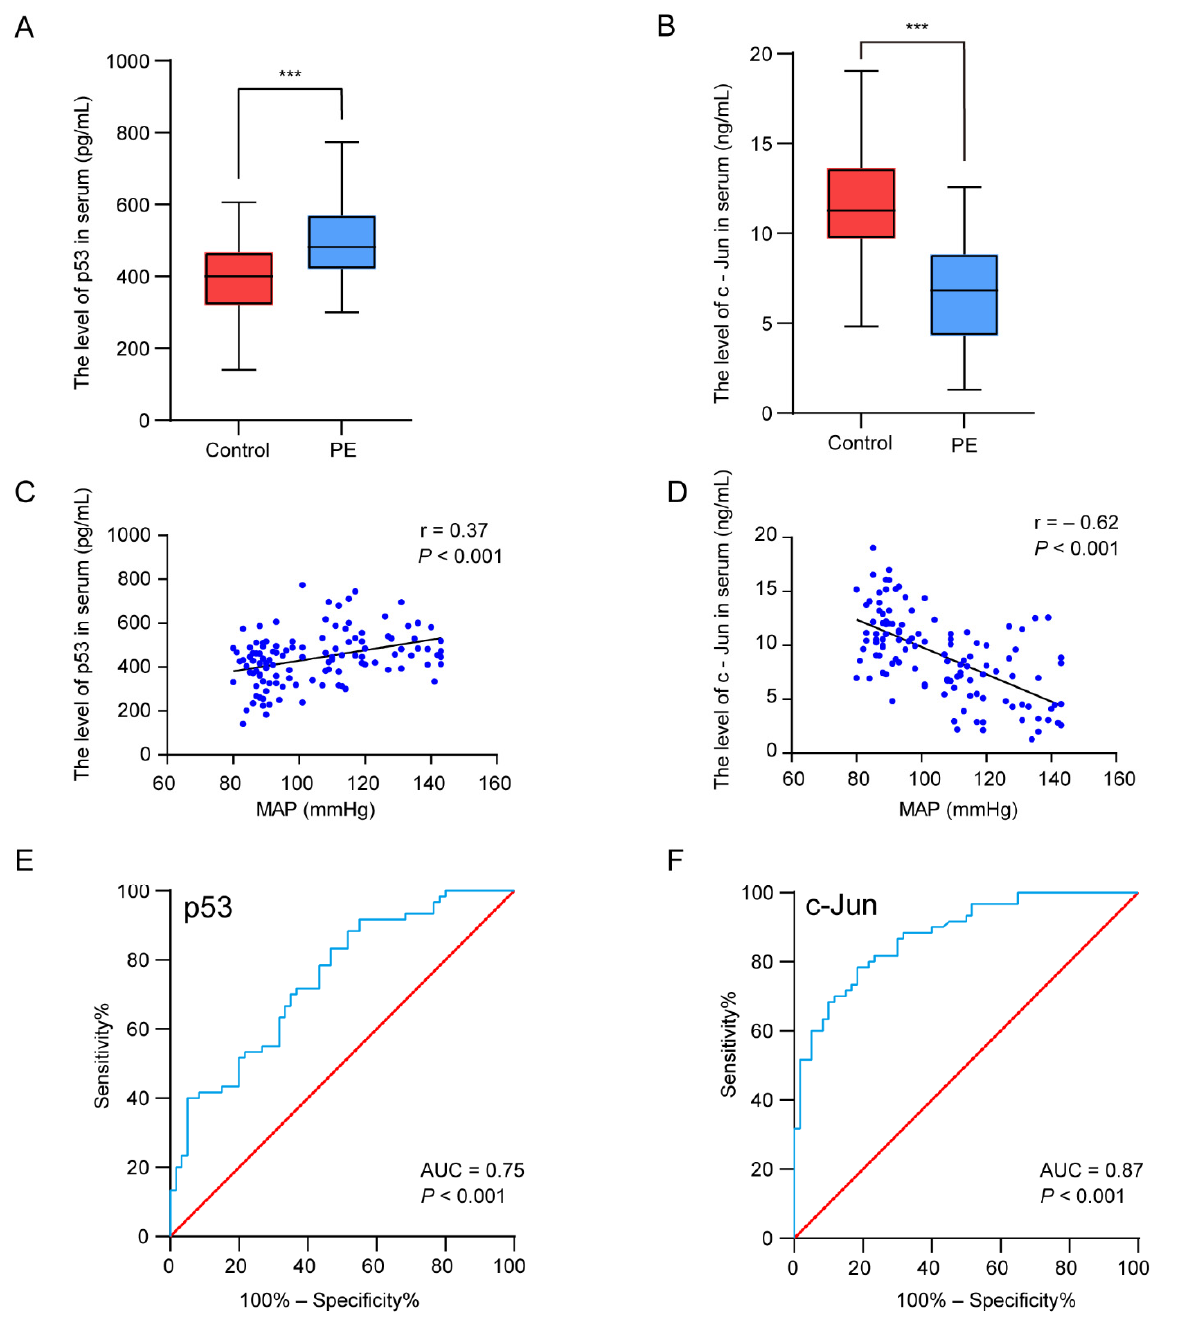
Figure 5. Experimental verification of the two hub genes, correlation analysis between the hub genes’ expression levels and clinical features, and the diagnostic accuracy analysis. ( A , B ) The concentration of p53 ( A ) and c-Jun ( B ) in serum. ( C , D ) Pearson correlation plots between MAP and p53 ( C ) and c-Jun ( D ). ( E , F ) The ROC curves were plotted to examine the diagnostic potential of p53 ( E ) and c-Jun ( F ). *** p < 0.001.